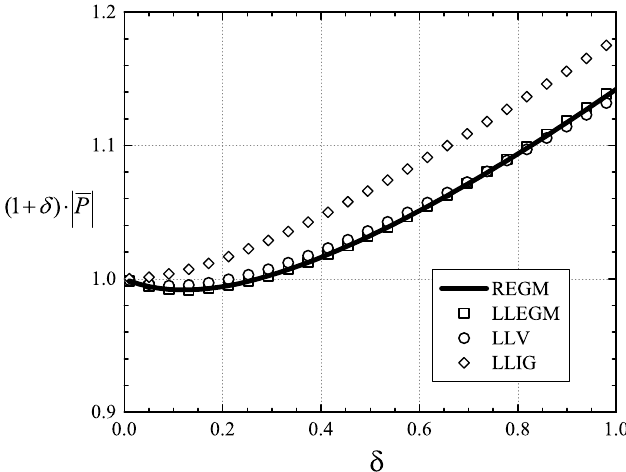
Figure 12. Scaled loss vs. δ at V ref = 5 V c and T ref = 1.05 T c . The speed number Λ = 50.